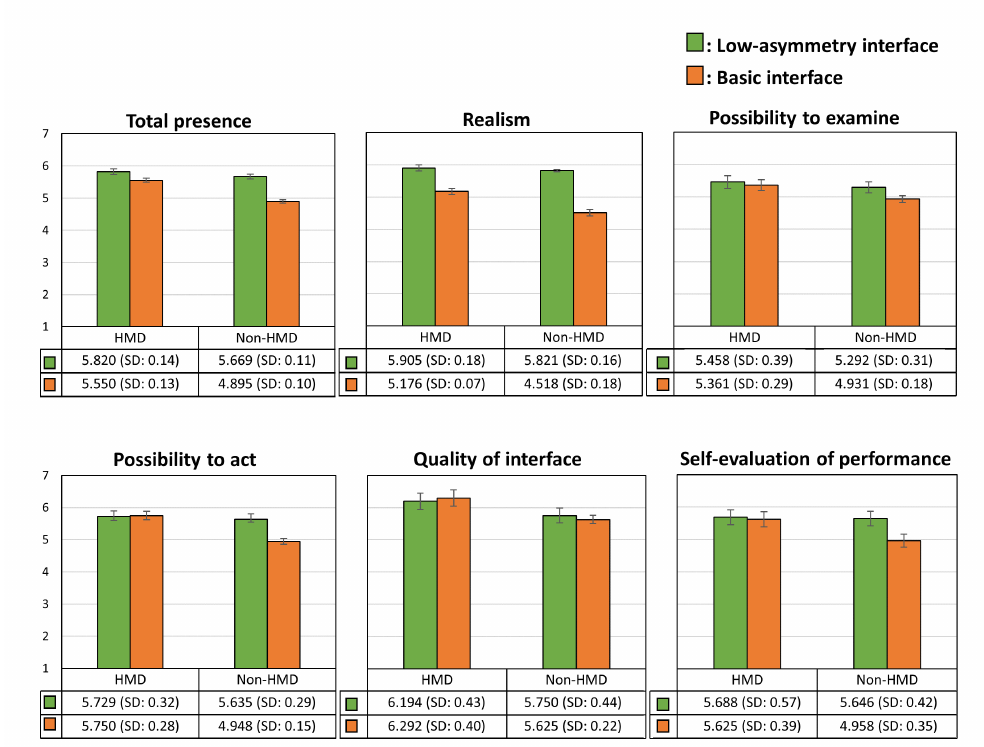
Figure 11. Presence questionnaire results for HMD and non-HMD